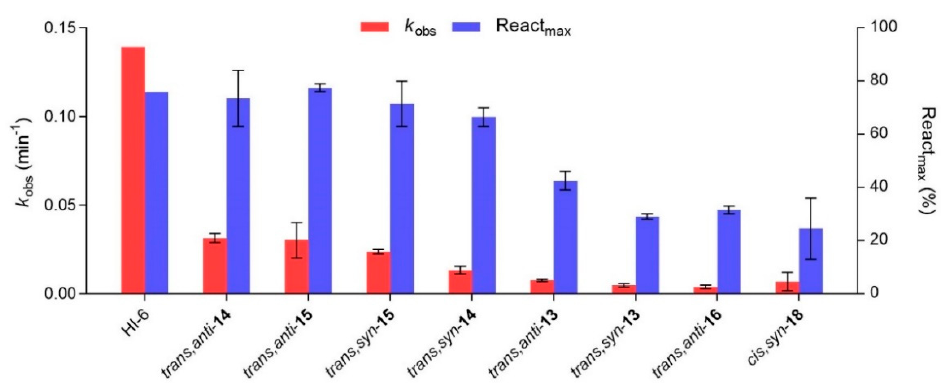
Figure 4. Reactivation of cyclosarin-inhibited human BChE with eight thienostilbene oxime deriva- tives and standard oxime HI-6 (0.1 mM) given as observed reactivation constant ( k obs ) and maximal reactivation in 22 h.